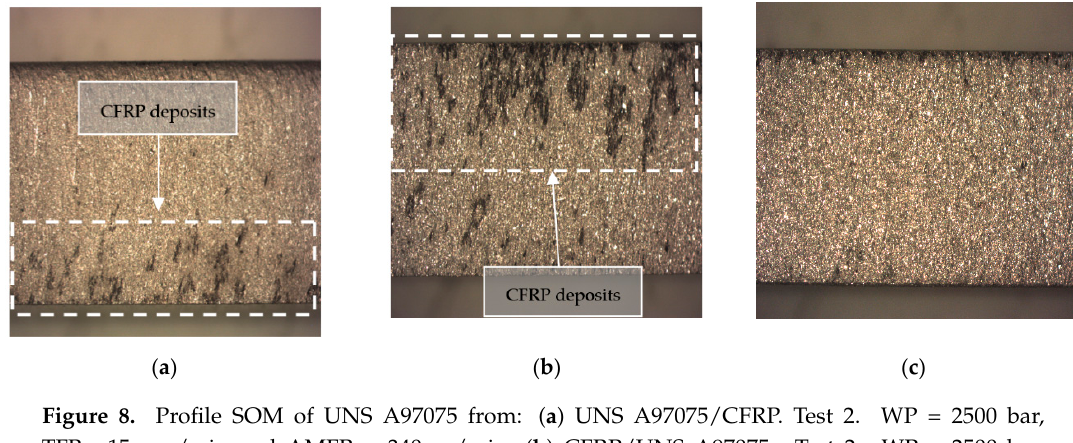
Figure 8. Profile SOM of UNS A97075 from: ( a ) UNS A97075/CFRP. Test 2. WP = 2500 bar, TFR = 15 mm/min and AMFR = 340 gr/min; ( b ) CFRP/UNS A97075. Test 2. WP = 2500 bar, TFR = 15 mm/min and AMFR = 340 gr/min; ( c ) CFRP/UNS A97075. Test 11. WP = 1200 bar, TFR = 45 mm/min and AMFR = 170 gr/min.